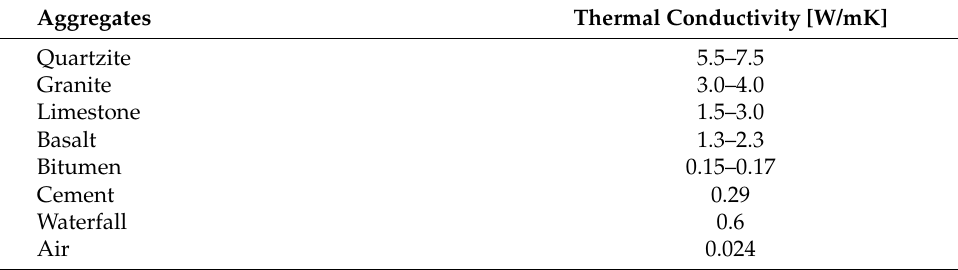
Table 3. Thermal conductivity of most used aggregates of the road